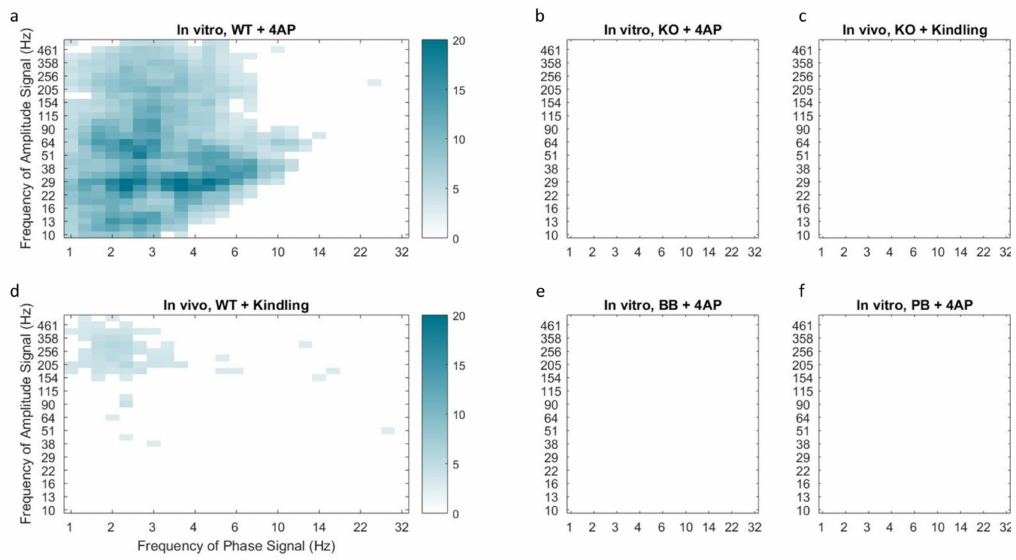
Figure 5. Median phase-amplitude cross frequency coupling comodulograms for the in vitro 4-AP slice model ( a , b , e , f ) and in vivo kindling model ( c , d ) following z-score normalization to baseline conditions. Cortical slices from mice in the KO group demonstrated reduced phase-amplitude coupling following incubation with 4-AP ( b ) or electrical kindling ( c ) as compared to WT counterparts ( a and d respectively). Coupling of delta phase to HF amplitude was observed in both models of hyper-excitability in control animals but was absent in Panx1 deficient mice, including those pretreated with Panx1 blockers BB-FCF ( e ) and probenecid ( f ). This finding is indicative of reduced epileptiform activity in the absence of functional